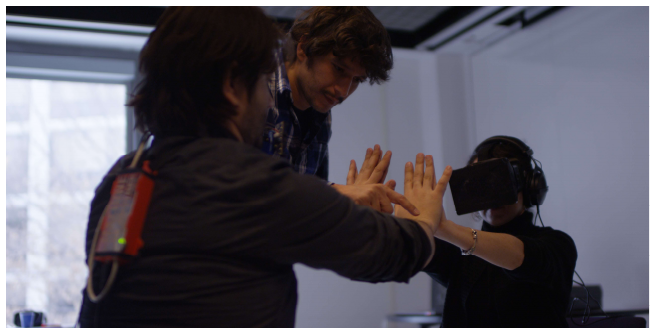
Figure 3. The experience of “the machine to be another”.